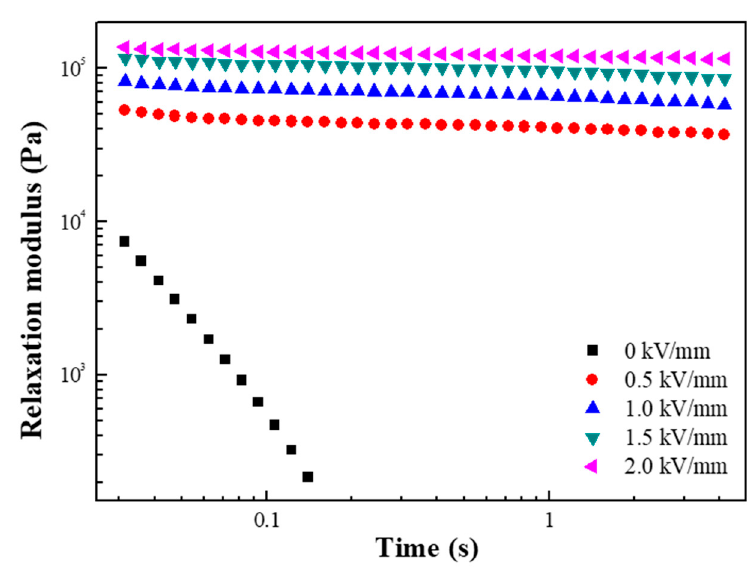
Figure 11. Time-dependent relaxation modulus of PDPA / Fe 3 O 4 -based ER fluid (10 vol%, 50 cSt silicone oil).